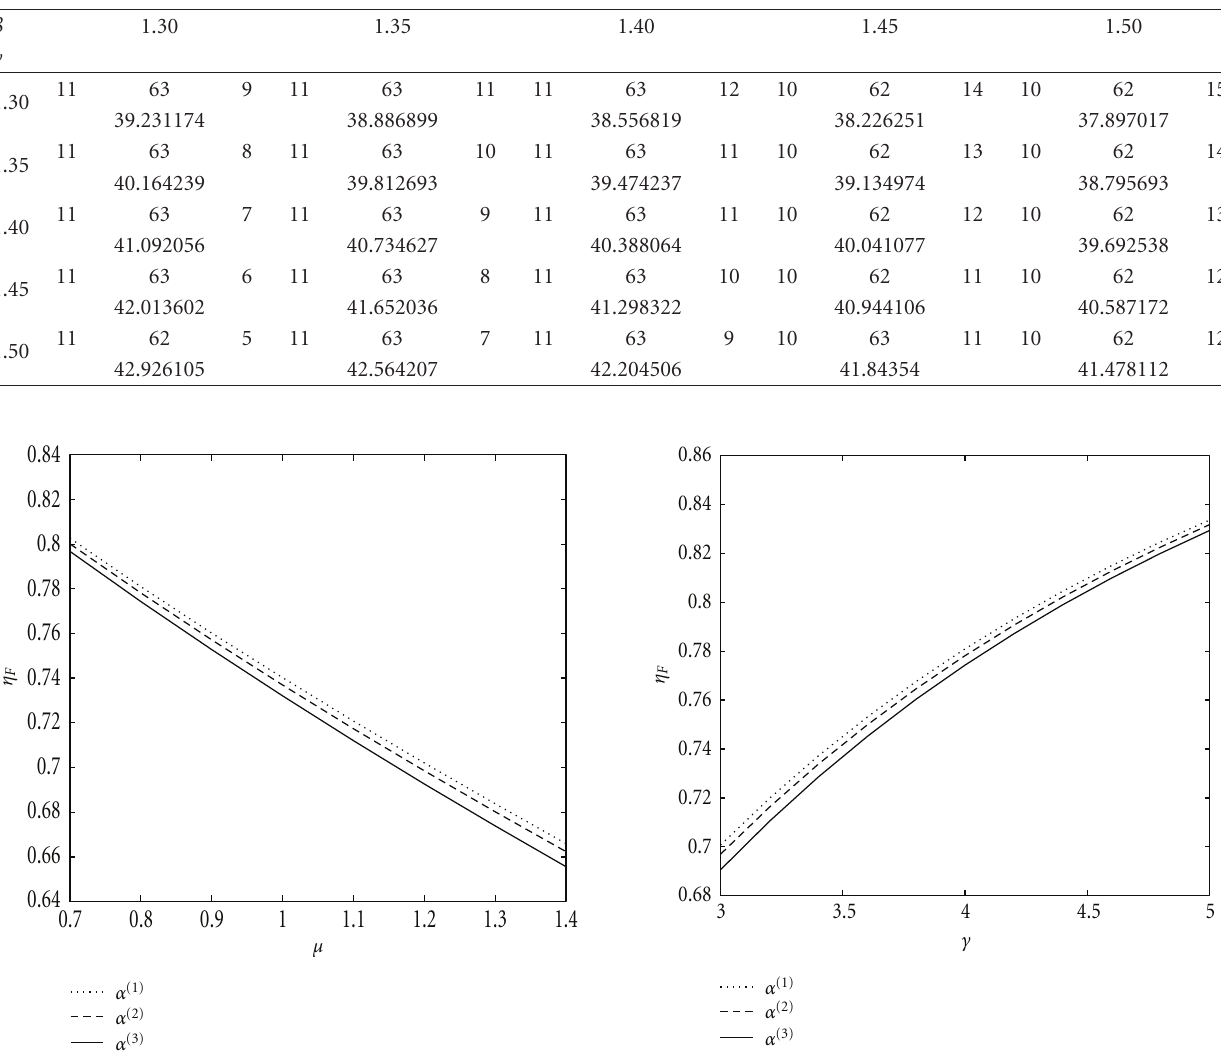
Table 8: Optimal values corresponding to various perishable rates and vacation time rates ( λ = 14, α = 4, μ = 4, p = 0 . 85).